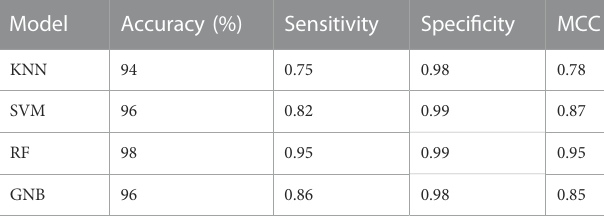
TABLE 3 Performance of models on the test set.